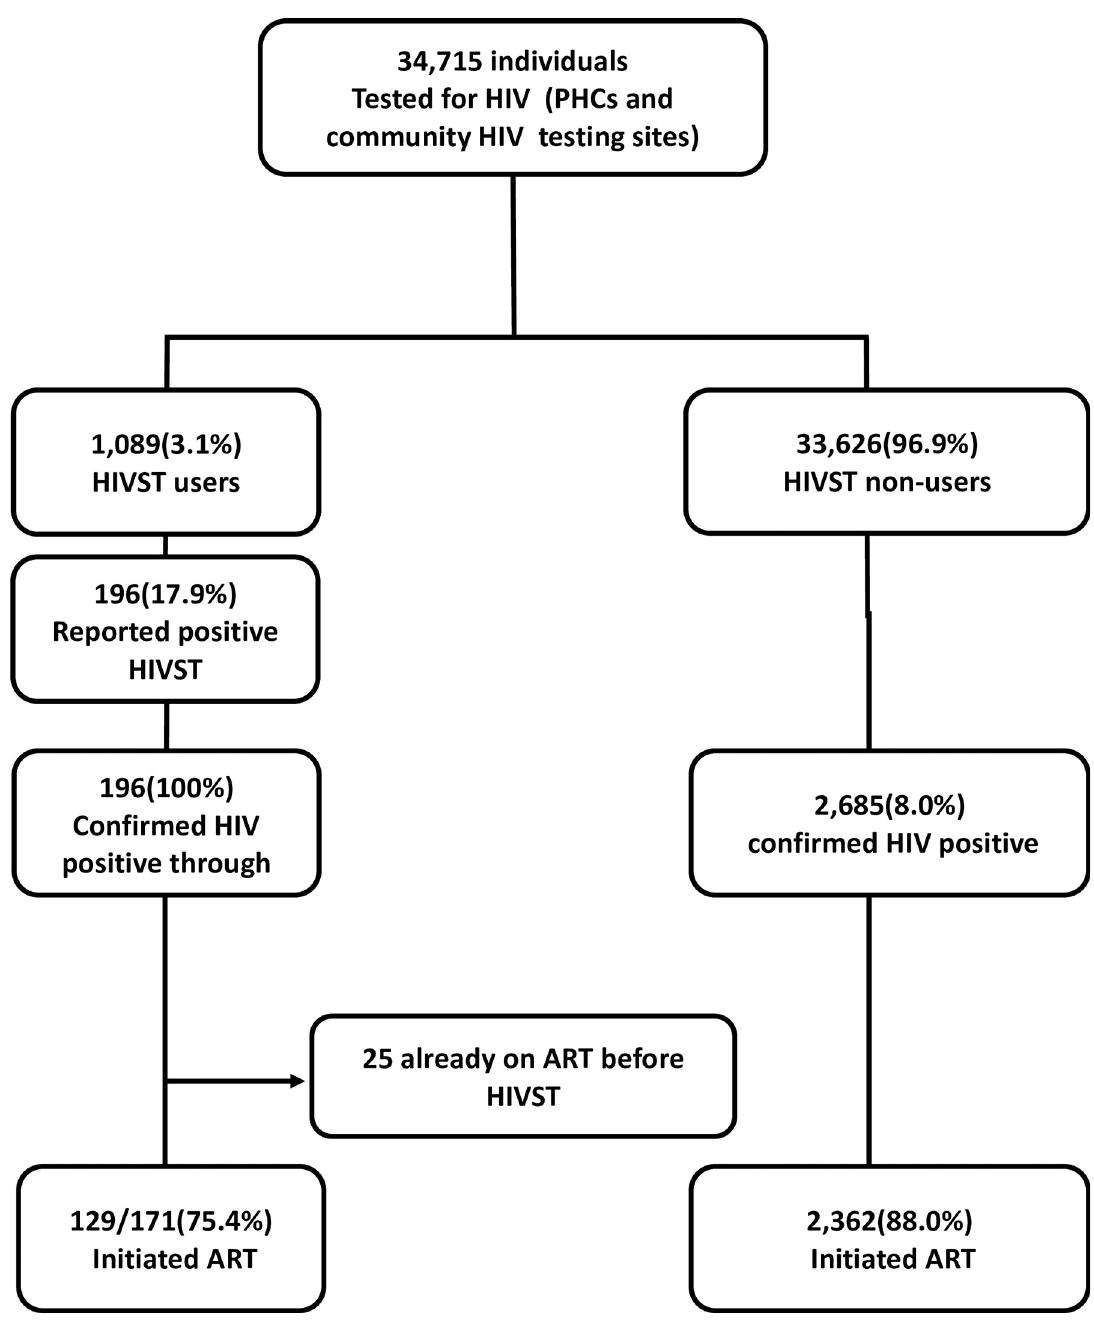
Fig 1. Flow diagram for passive follow up